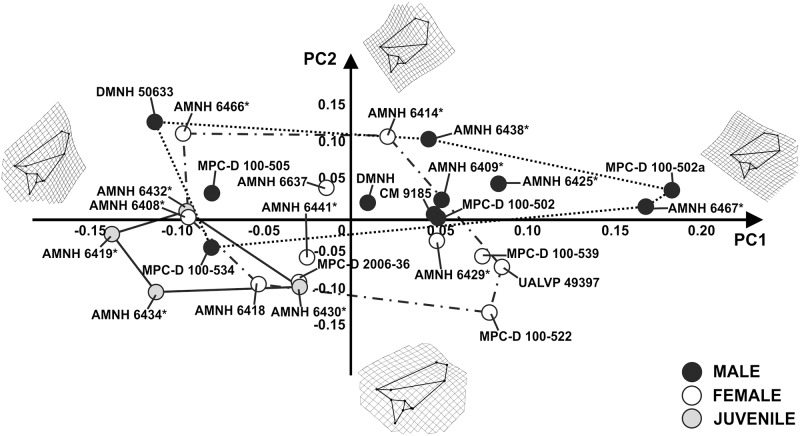
Principal Component Analysis performed on the frills.The continuous line represents “juvenile” morphospace. The dotted line represents “male” morphospace and the dashed line represents “female” morphospace. Asterisks indicate specimens shared with Dodson [25].